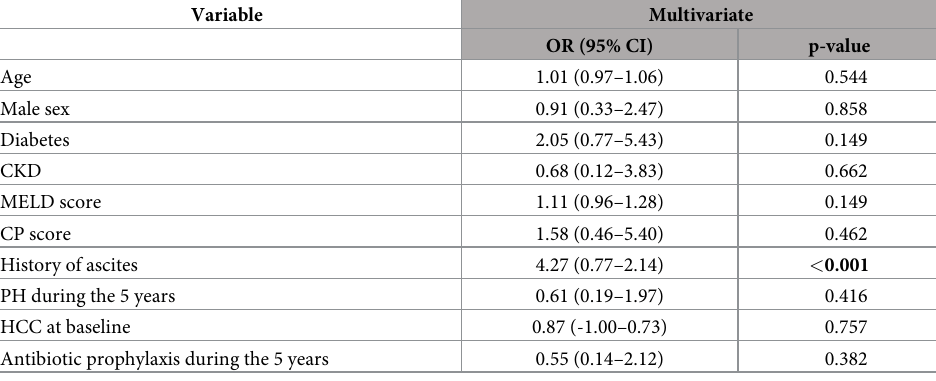
Table 4. Multivariate analysis with infections (both MDROs and multi-drugs sensible organisms) as dependent